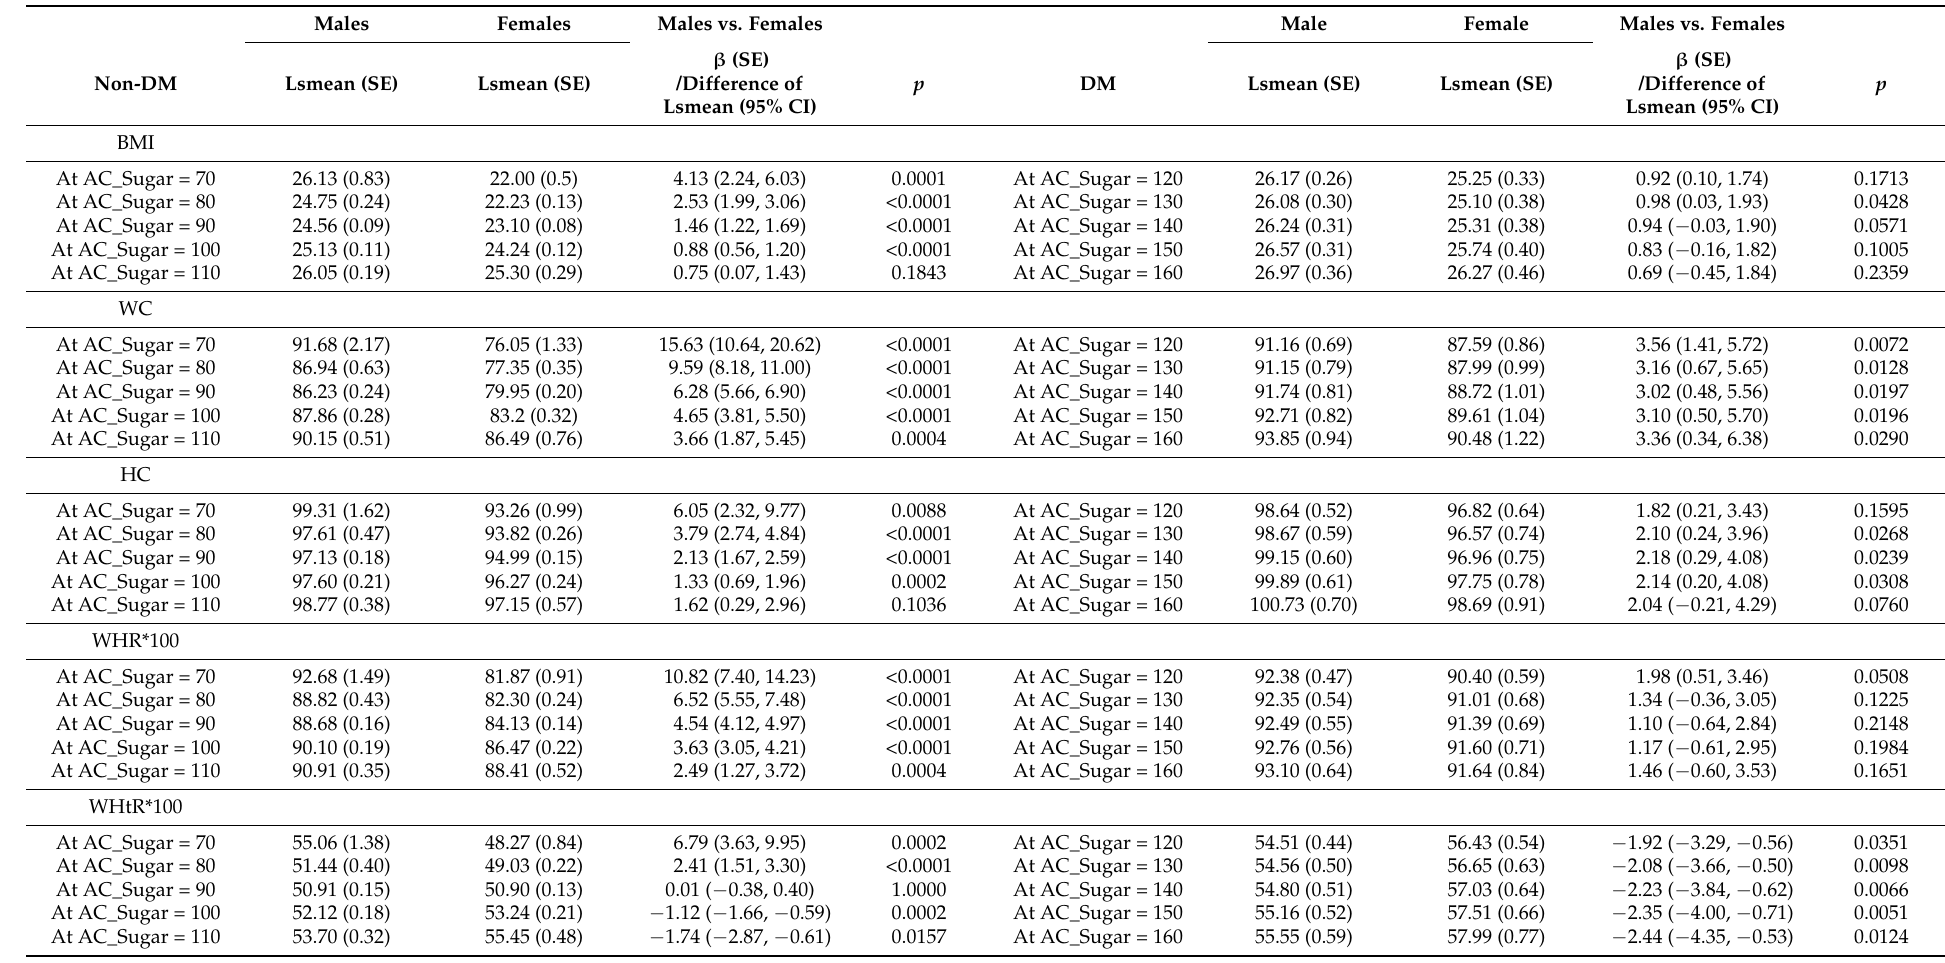
Table 3. Separate trends between obesity-related indices and fasting glucose between males and females with and without DM. Males Females Males vs. Females Male Female Males vs.